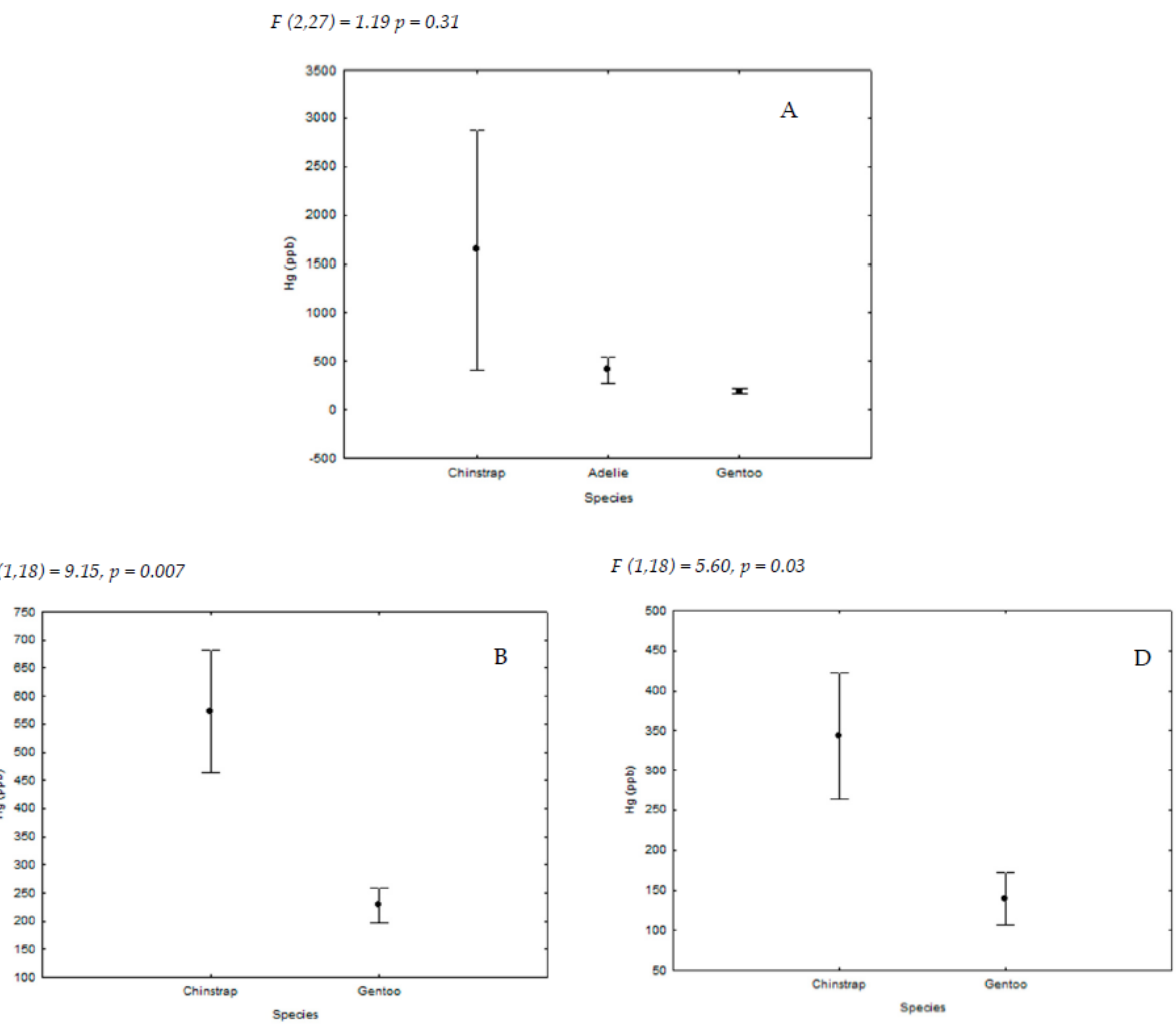
Figure 4. Mean ( ± SE) Hg concentration in feathers of the three studied species from the islands of (A) King George, (B) Livingston, and (D) Ronge. For sample sizes, see Table 1.